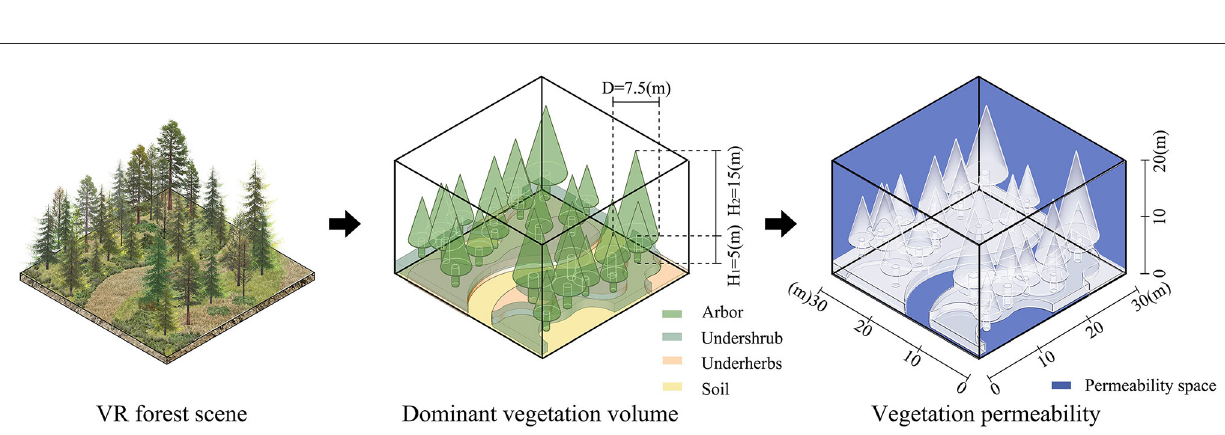
FIGURE3 The experimental flow chart in vegetation permeability analysis.